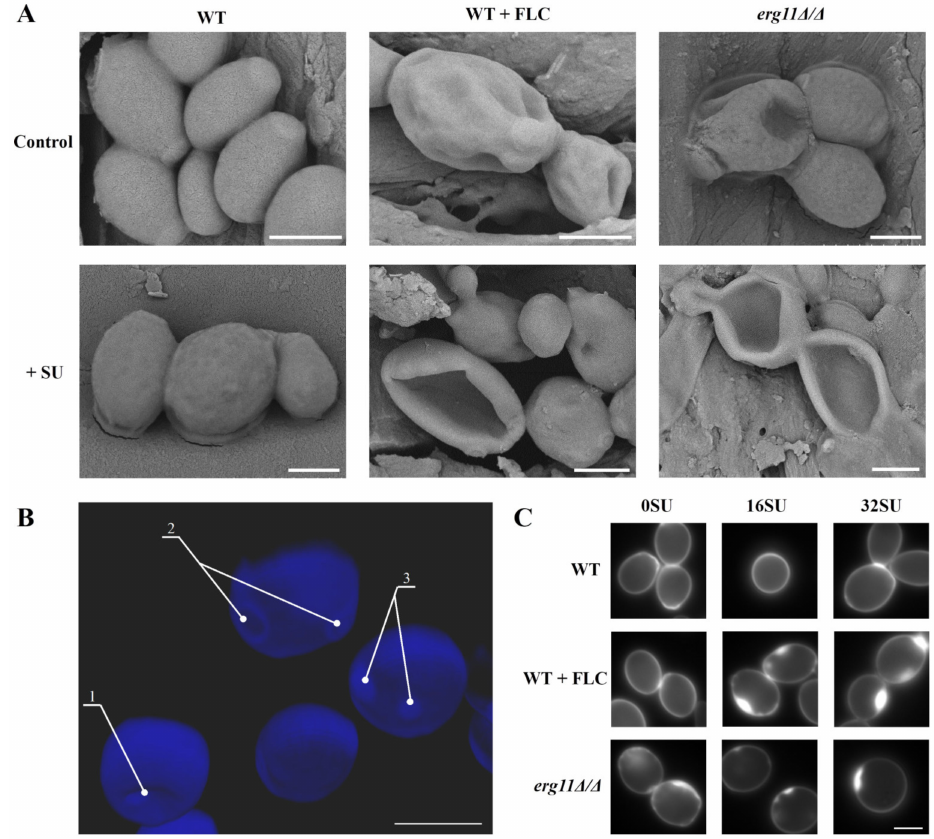
Figure 3. Scanning electron microscope (SEM) images of C. albicans CAF2-1 (WT) and KS028 ( erg11 ∆ / ∆ ) strains. (( A )—upper panel) images of C. albicans cells untreated (control) or treated with 1 µ g / mL fluconazole. (( A )—lower panel) images of C. albicans cells treated with 32 µ g / mL SU, ( B ) Confocal microscope z-stack projection showing C. albicans KS028 ( erg11 ∆ / ∆ ) chitin staining by calcofluor white dye (CFW); 1—surface dimples, 2—septa, 3—localized chitin accumulations. Scale bars in all images are equal to 2.5 µ m. ( C ) C. albicans chitin was stained with calcofluor white (CFW) in C. albicans CAF2-1 (WT) untreated and treated with 16 or 32 µ g / mL SU. The C. albicans CAF2-1 (WT) strain was simultaneously treated with 0.5 µ g / mL fluconazole and 16 or 32 µ g / mL SU. C. albicans KS028 ( erg11 ∆ / ∆ ) was also treated under the same conditions. Images are representative of at least three independent experiments. Scale bars are equal to 2 µ